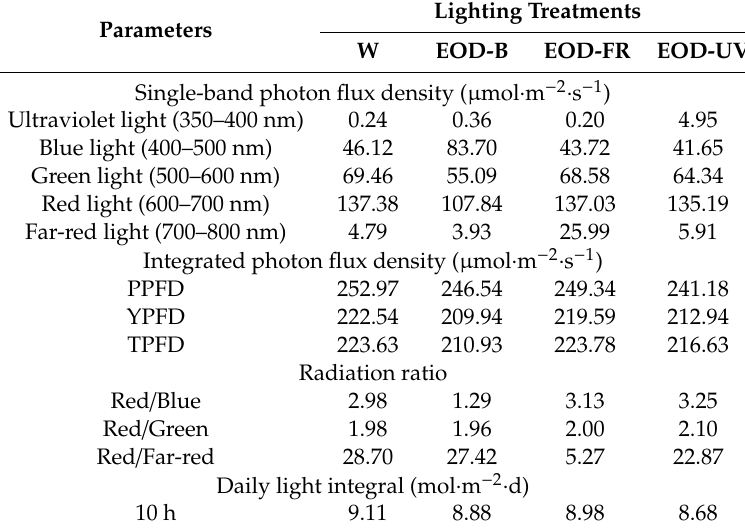
Table 1. Lighting parameters.